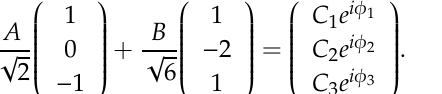
| 1 / F 2 kHz. 𝑟𝑟 = | 𝐹𝐹 1 / 𝐹𝐹 2 | 𝜔𝜔 = 33.25